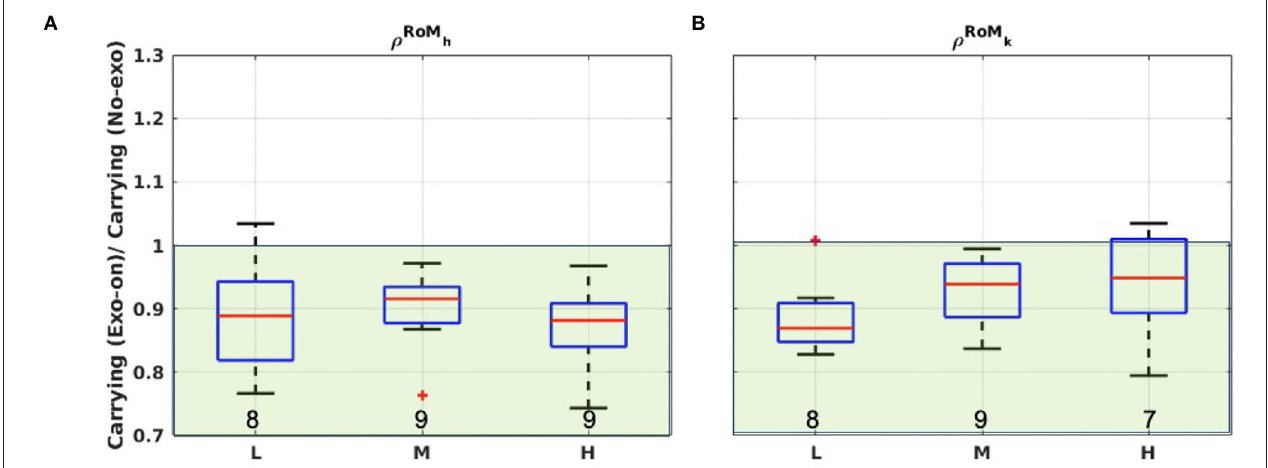
FIGURE 6 | Boxplots representations for ρ RoM h and ρ RoM k considering carrying in Exo-on and No-exo condition. Two different joints are analyzed: (A) Hip and (B) knee. L, M, and H refer to the light, medium, or heavy loading condition. Green-shaded areas identify the regions where ρ x i < 1 (i.e., the exoskeleton reduces the RoMs). Numeric values at the bottom of each box report the value of γ .